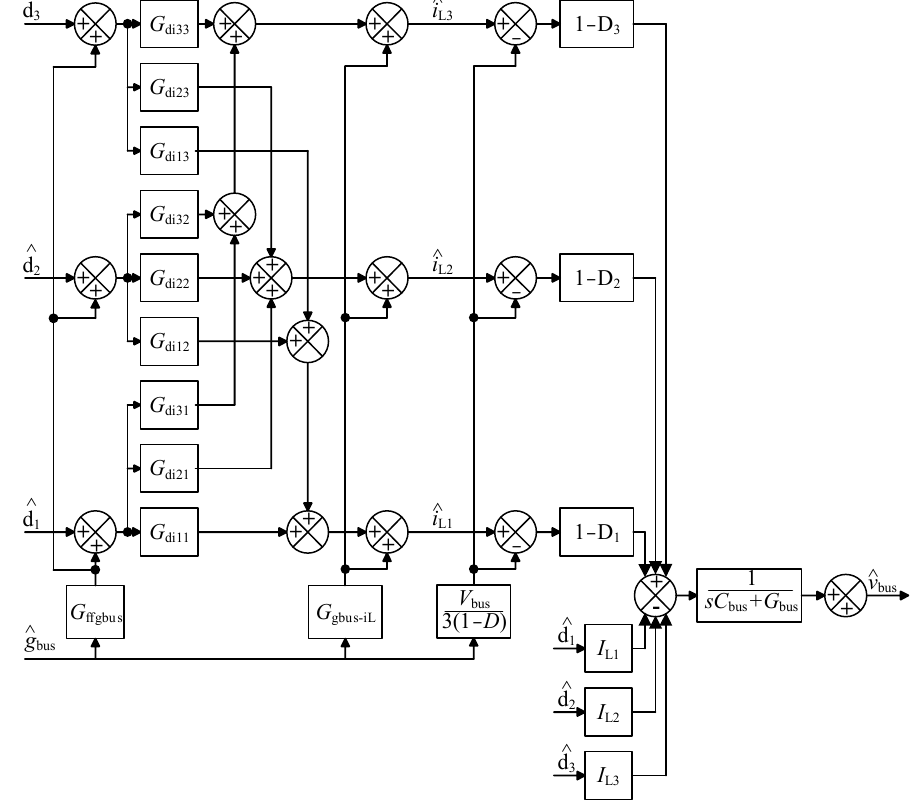
Figure 5. The control diagram of the feedforward to eliminate the disturbance of the bus load.